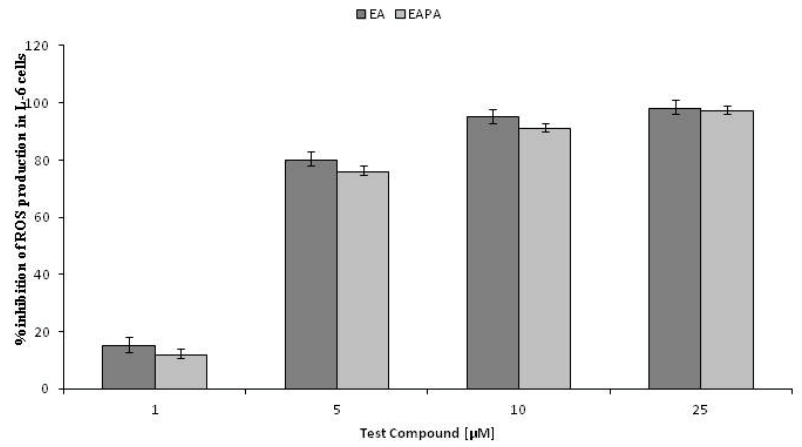
Figure 2. Influence of EA and EAPA on the levels of intracellular ROS formed in L-6 myoblasts after exposure to cumene hydroperoxide. Data represent mean ± S.D. from three independent experi- ments performed in triplicates. There were no significant differences in the activities between EA and EAPA in all the cases.